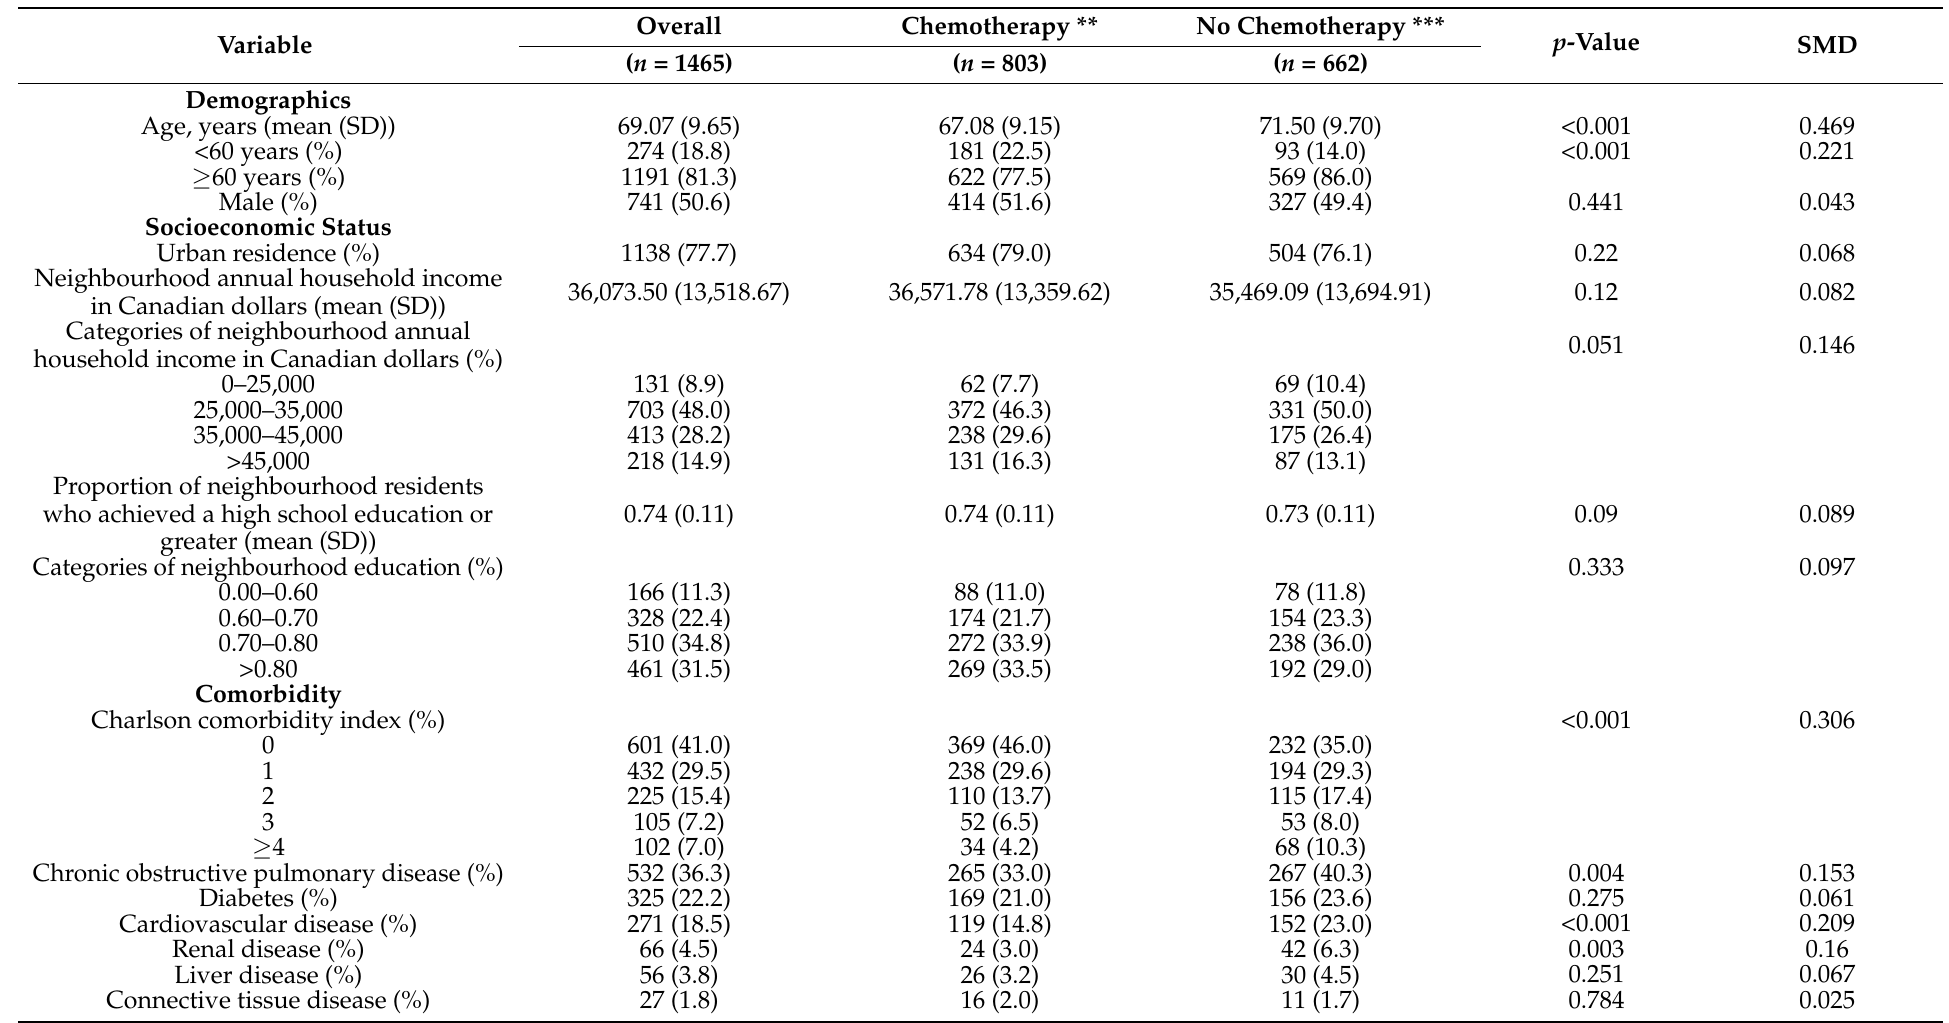
Table 1. Baseline demographics and clinical characteristics of the de novo extensive stage small cell lung cancer